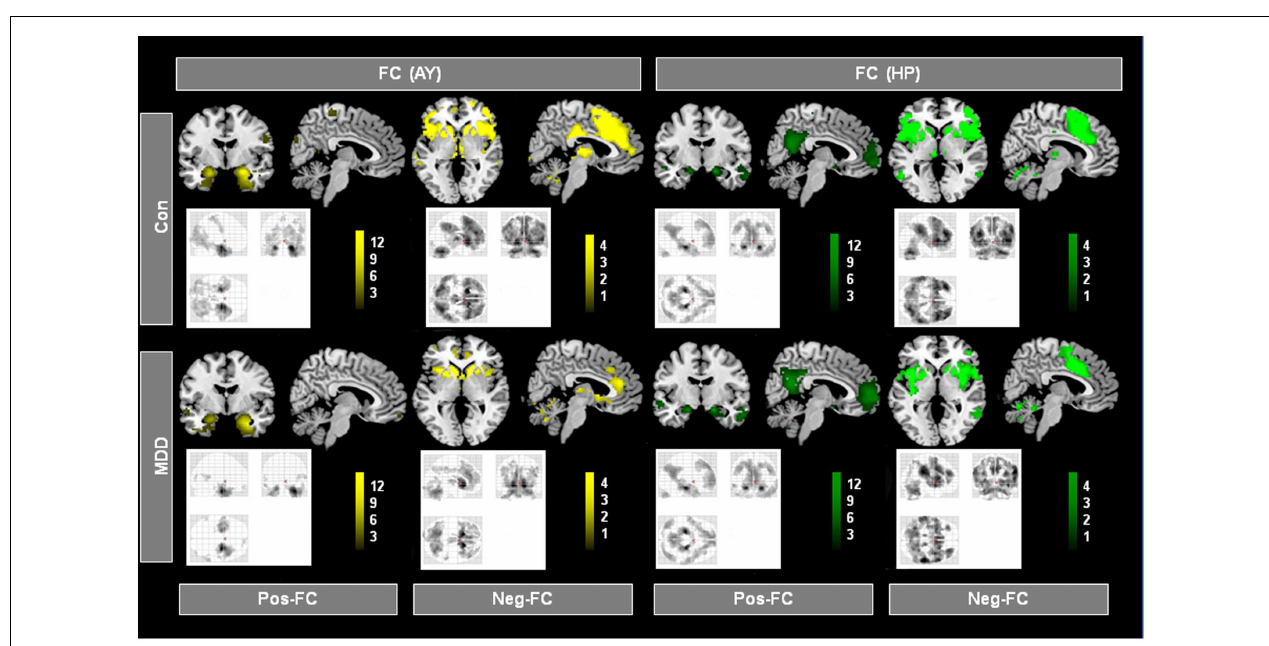
for group and hemisphere for the HP and AY, respectively.Yellow and green maps, which were superimposed on a single-subject high resolutionT1 image, represent results of corresponding post hoc t -tests that reflect positive and negative FC (Pos-FC and Neg-FC, respectively) for each group and seed region ( p < 0.05, FDR corrected; bars represent range of t